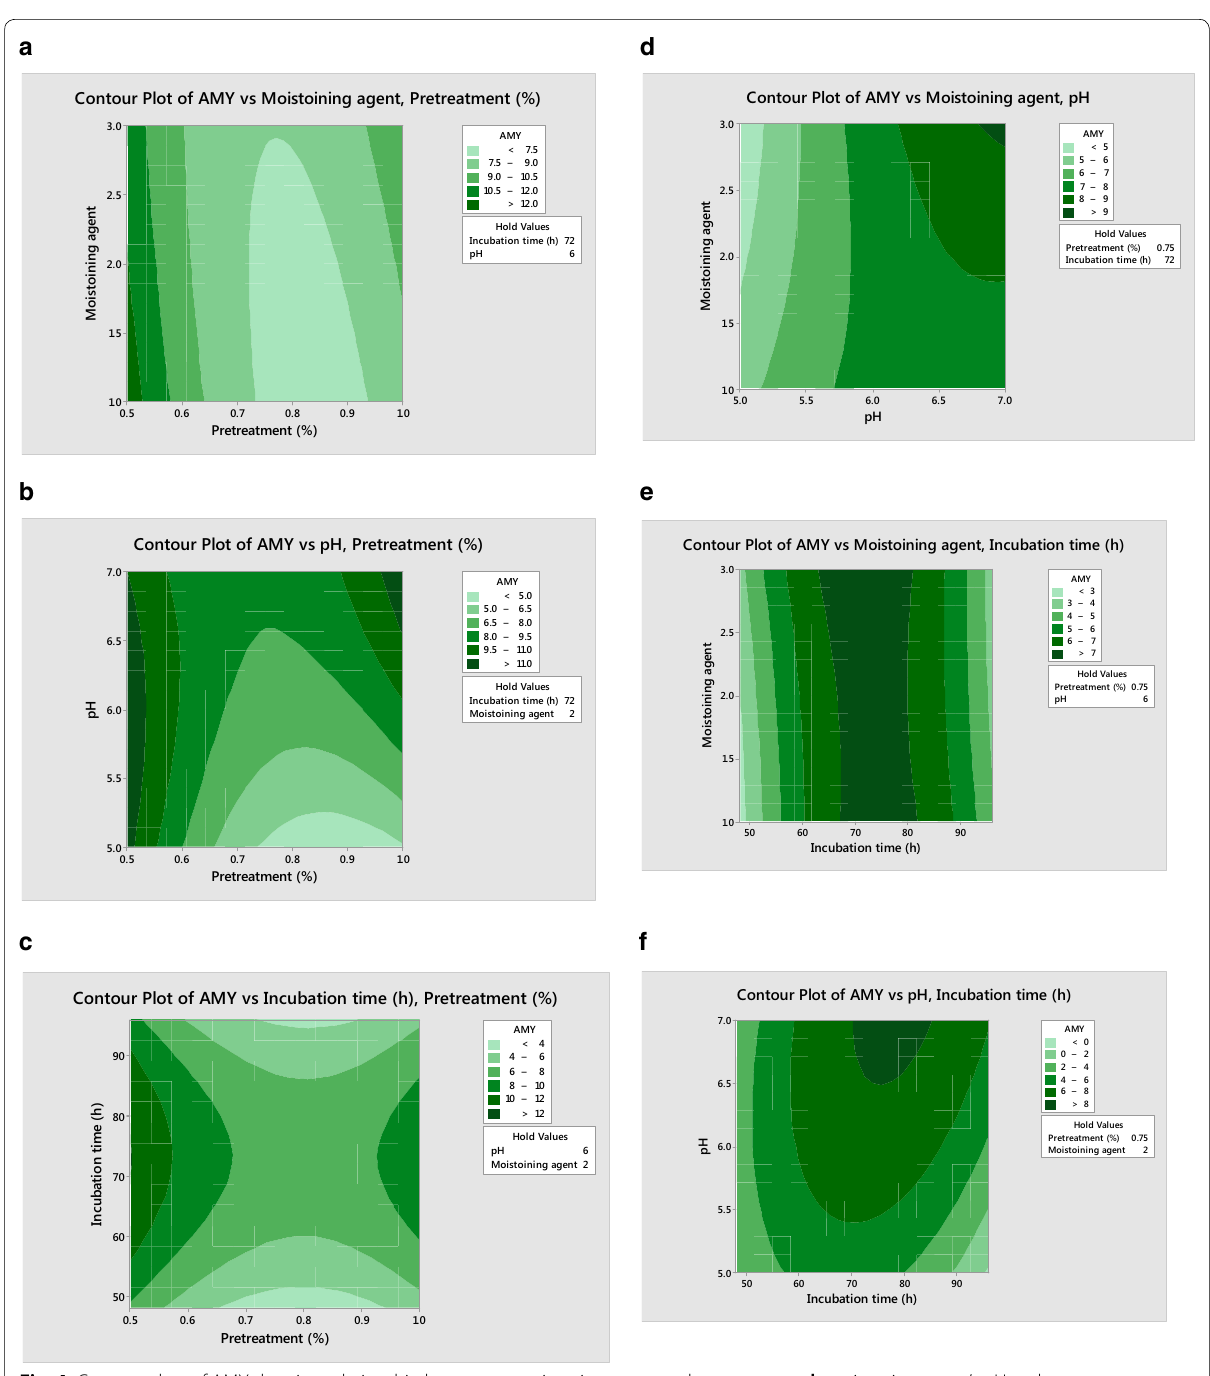
Fig. 4 Contour plots of AMY showing relationship between a moistening agent and pretreatment, b moistening agent’s pH and pretreatment, c incubation time and pretreatment, d moistening agent and it’s pH, e moistening agent and incubation time, and f moistening agent’s pH and incubation